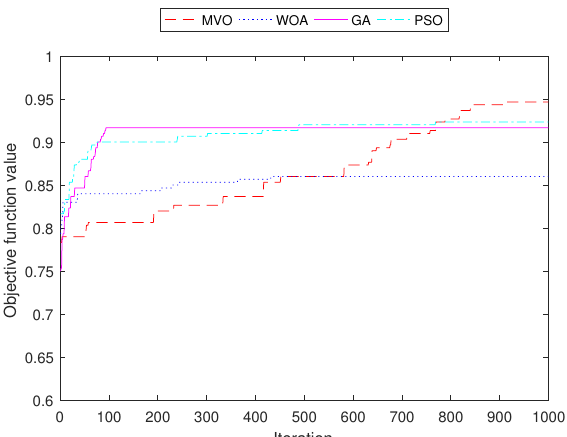
Figure 13. Performance comparison of the objective function value for INS-3 with 150 mesh clients.